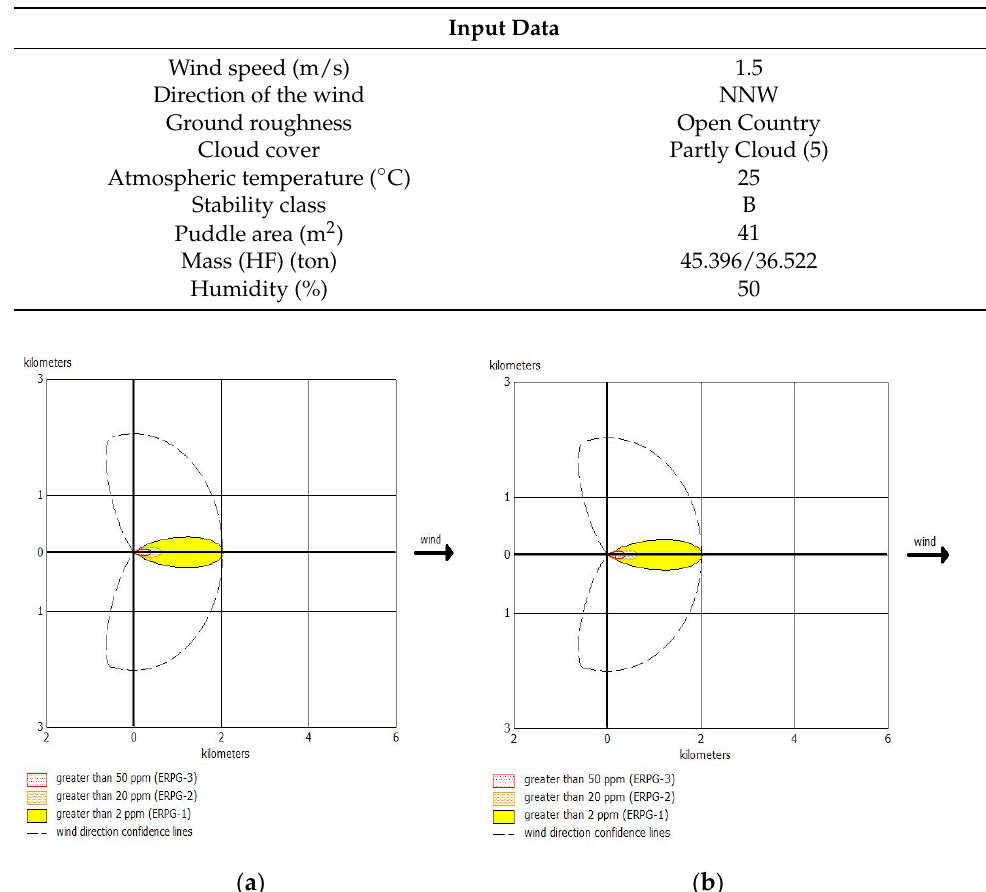
Figure 9. The range of ERPGs when the HF leak occurs. ( a ) In the case of no mitigation system; ( b ) In the case a mitigation system is operated. The difference in ERPG-2 is only 4 m (638 m and 634 m). The zero-point in figures is the location of a vessel and X-axis is the wind direction.